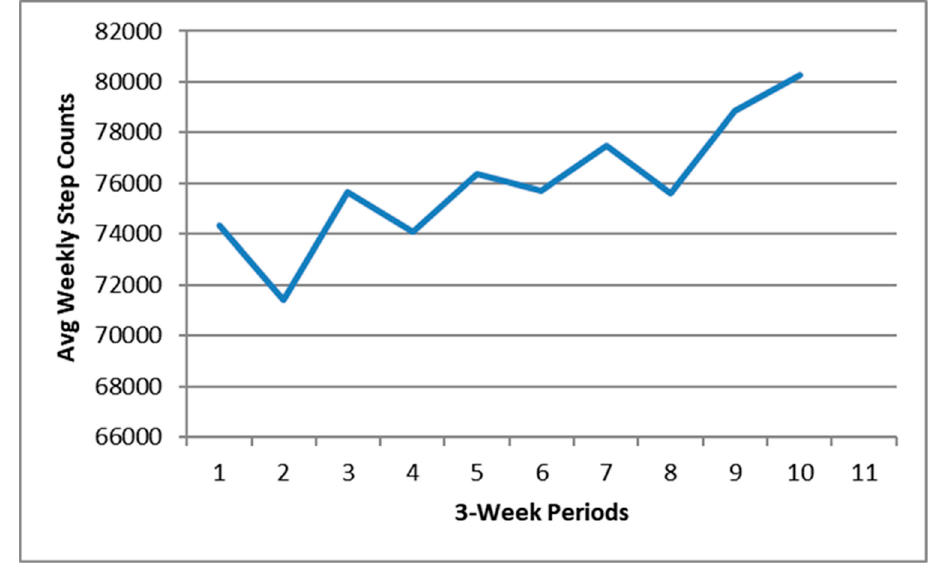
Figure 3. Three week moving average for the 12-week activity tracker group outdoor health walk ( n = 13 walkers).